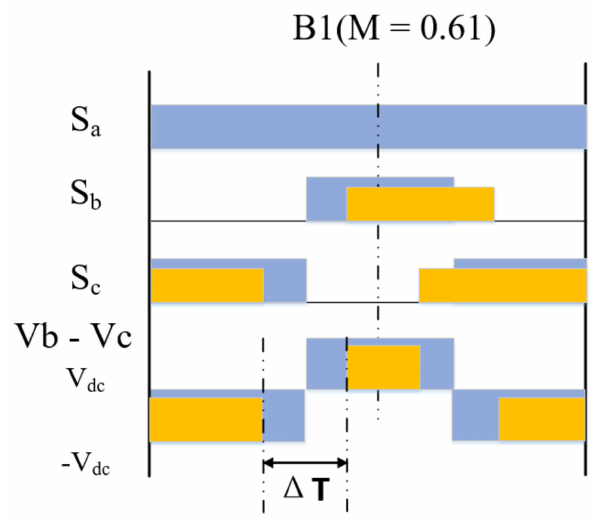
Figure 9. Solution for the small zero-voltage time interval between line–line pulse reversals.